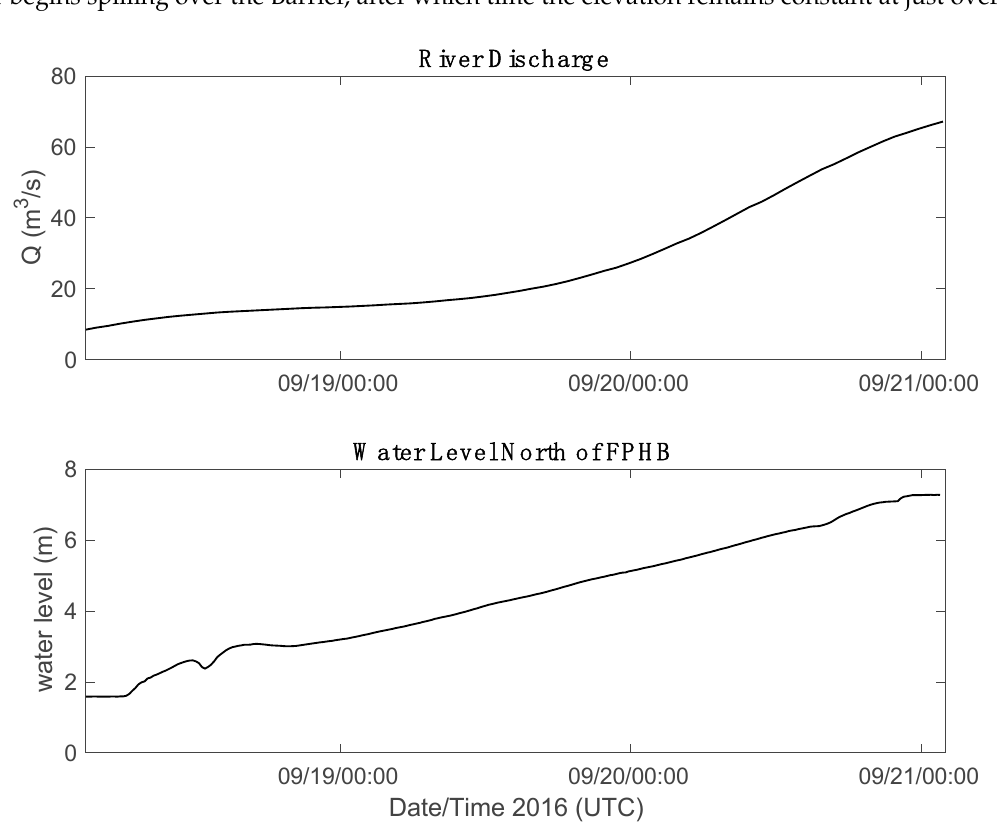
Figure 12. Combined (Woonasquatucket and Moshassuck Rivers) river discharge during hurricane Rhody computed from the PRMS model and applied as inflow forcing in ADCIRC / SWAN (top). The model water level just north of the (closed) FPHB is shown in the bottom plot.